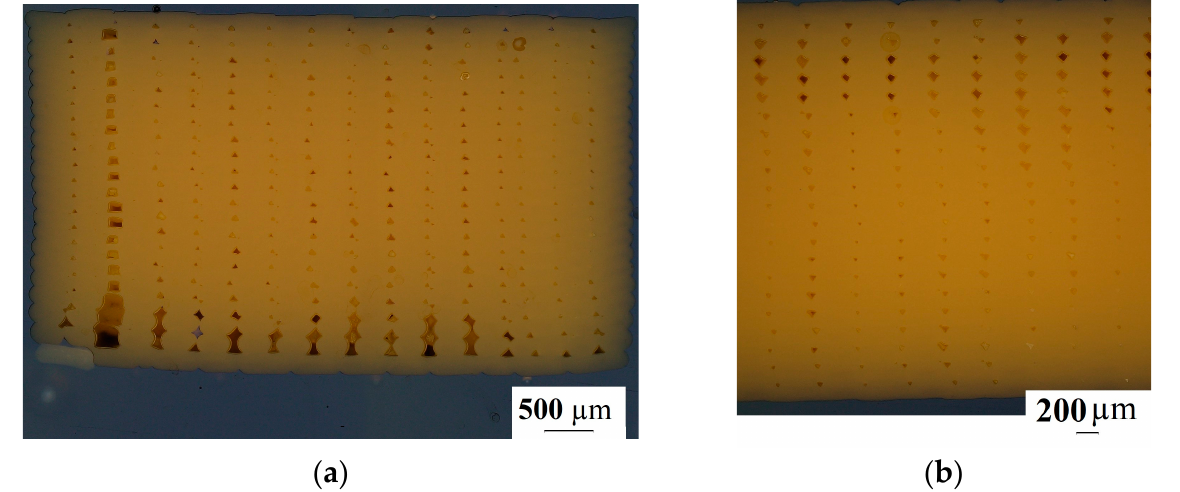
Figure 7. The test specimens’ cross-sections. ( a ) Perpendicular cross-section of a horizontally printed specimen; ( b ) perpendicular cross-section of a vertically printed specimen.